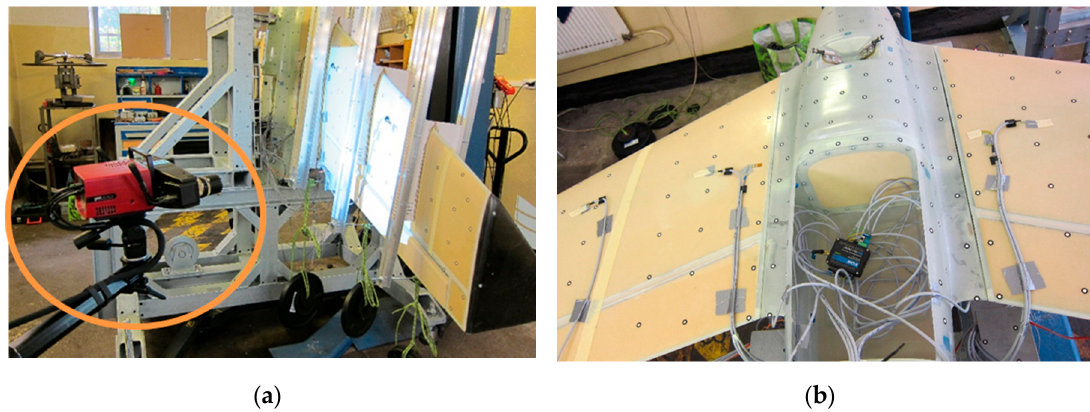
Figure 13. Test rig and RPAS configuration for all stages of static test ( a ) take-off (model) ( b ) take-off (execution) ( c ) flight (model) ( d ) flight (execution) ( e ) parachute release (model) ( f ) parachute release (execution).